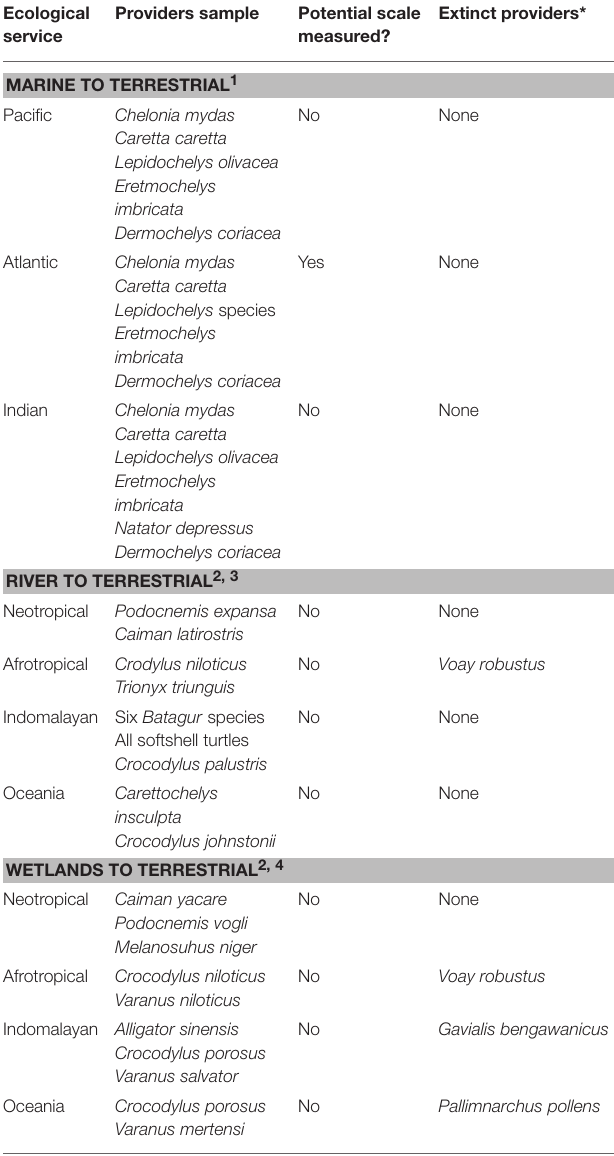
TABLE 2 | Examples of large tropical reptiles as nutrient linkers. Ecological